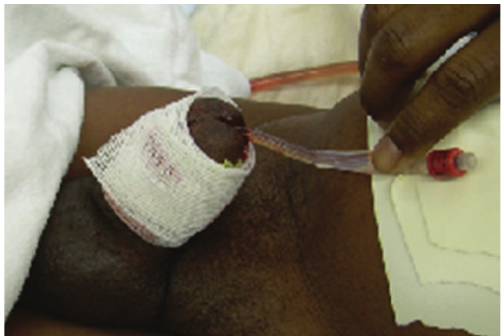
Figure 5: Post-operative